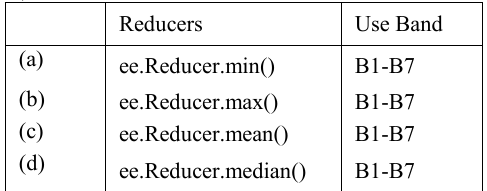
Table 4. Selected reduce